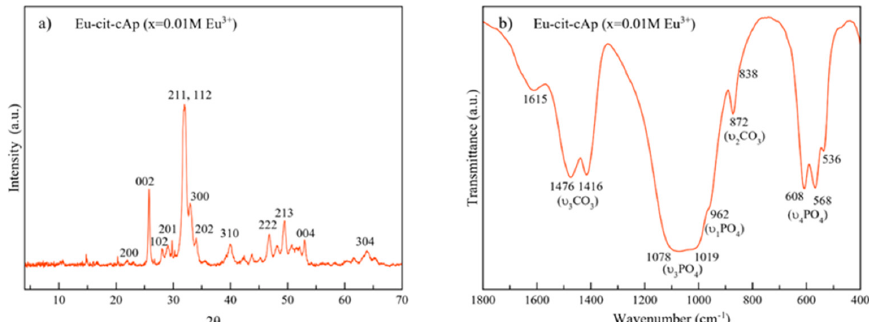
Figure 2. ( a ) XRD pattern of Eu:cit-cAp prepared by thermal decomplexing of Ca/Eu/citrate/phosphate/carbonate solutions [27]; ( b ) FTIR spectrum of Eu:cit-cAp.